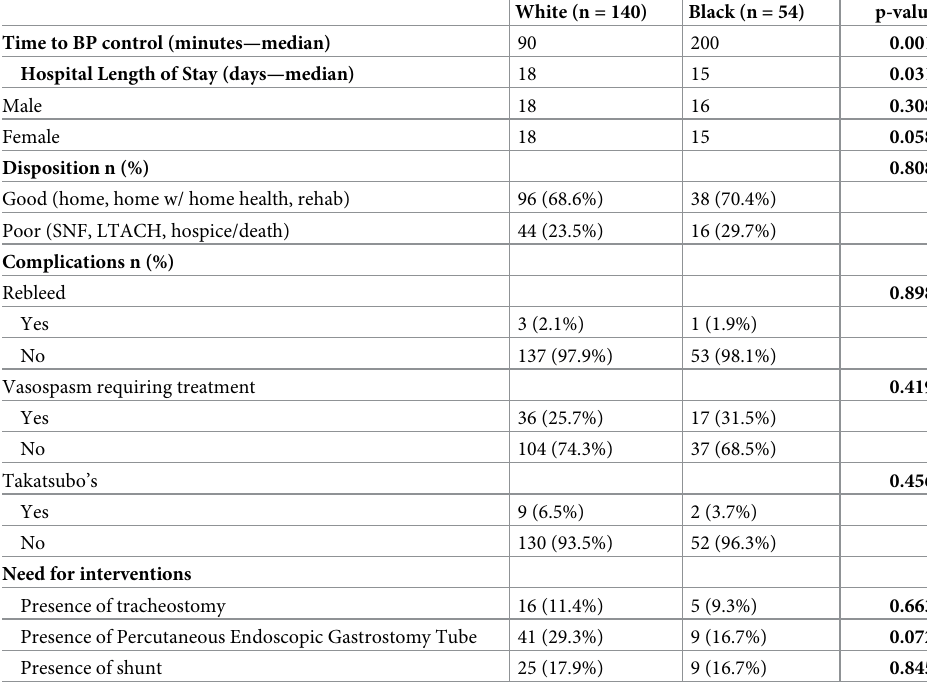
Table 2. Management and clinical